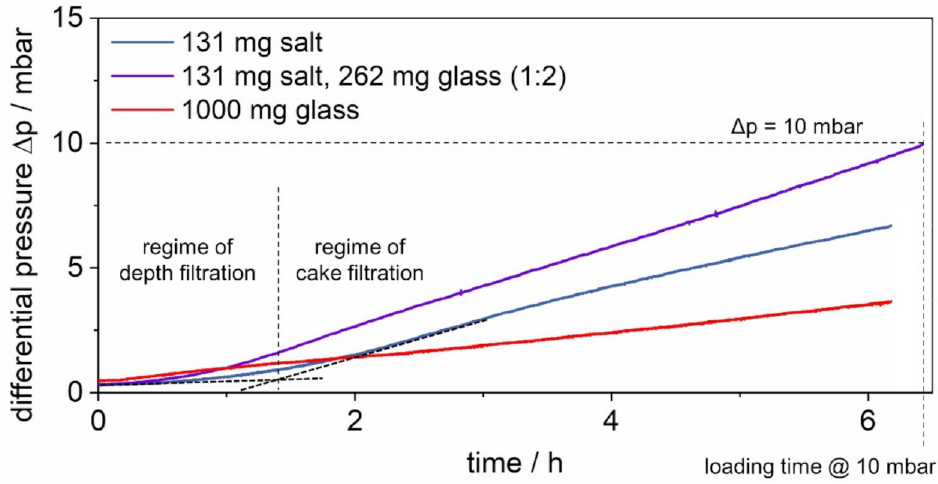
Figure 4. Differential pressure evolution during characteristic particle loading experiments of the salt-laden, the salt–glass-laden (ratio 1:2), and the glass-laden filter. The lowest stable salt–glass ratio with the disperser at hand is 1:2. This ratio is used to load the filter up to a common final differential pressure for the regeneration of surface filters of 10 mbar. For multiple repetitions, ∆ p = 10 mbar was reached after 6.2 h on average, resulting in a loading of 131 mg salt and 262 mg